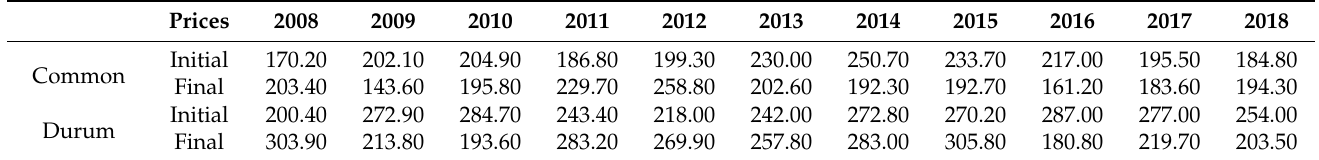
Table 1. Initial and final prices (euro by tonne) in each year for common and durum wheat.